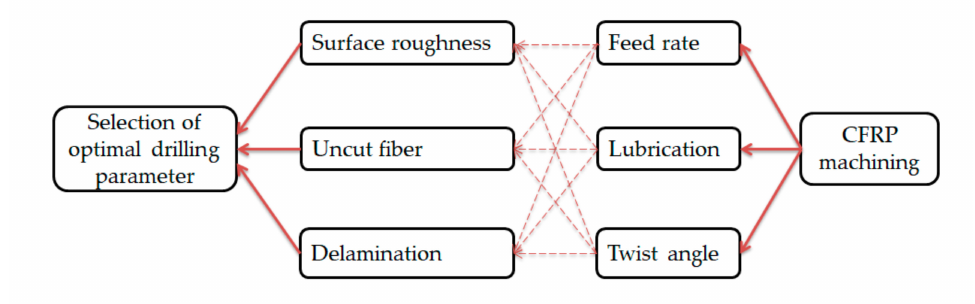
Figure 1. Marking diagram of carbon fiber reinforced plastic (CFRP) drilling process parameter election.